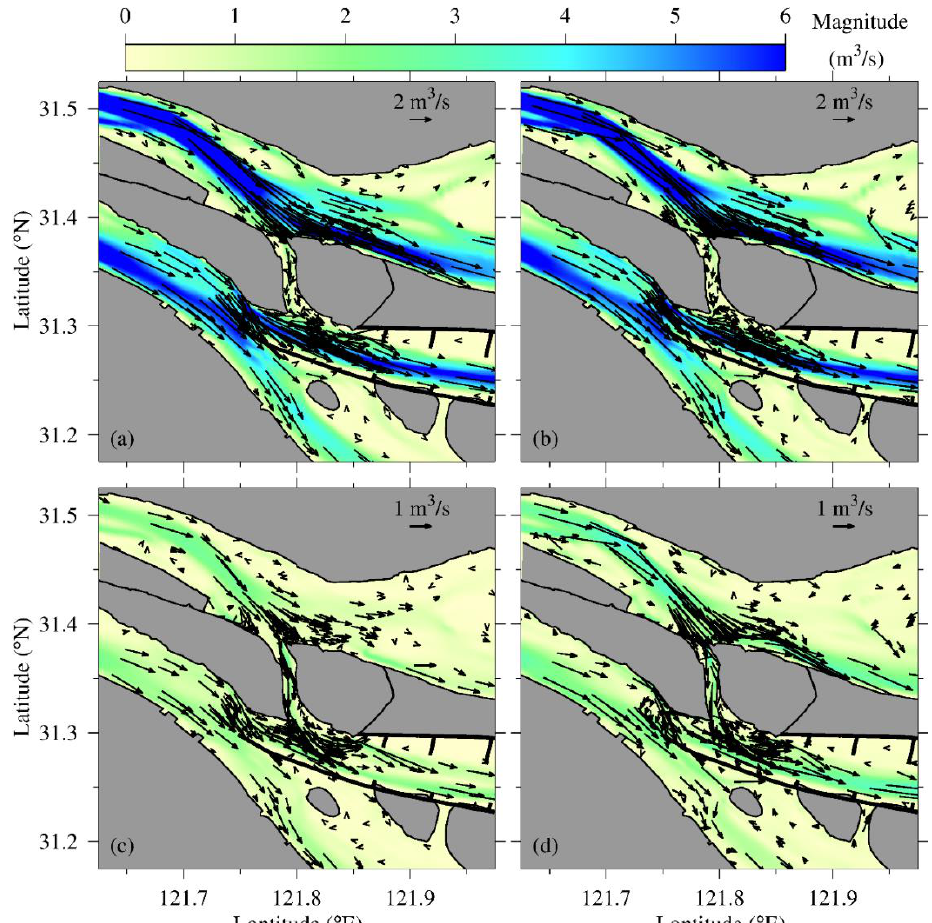
Figure 11. Residual water transports in EX1 ( a , b ) and EX2 ( c , d ) during neap tide (left panel) and spring tide (right panel).